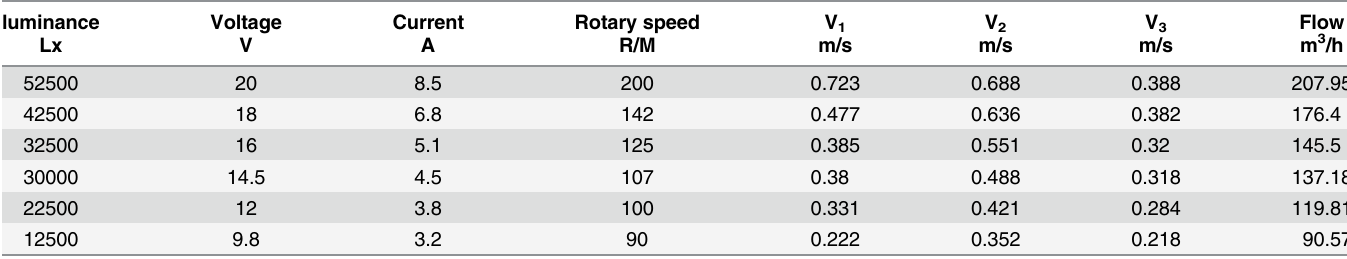
Table 1. Working status of the SMWM in different